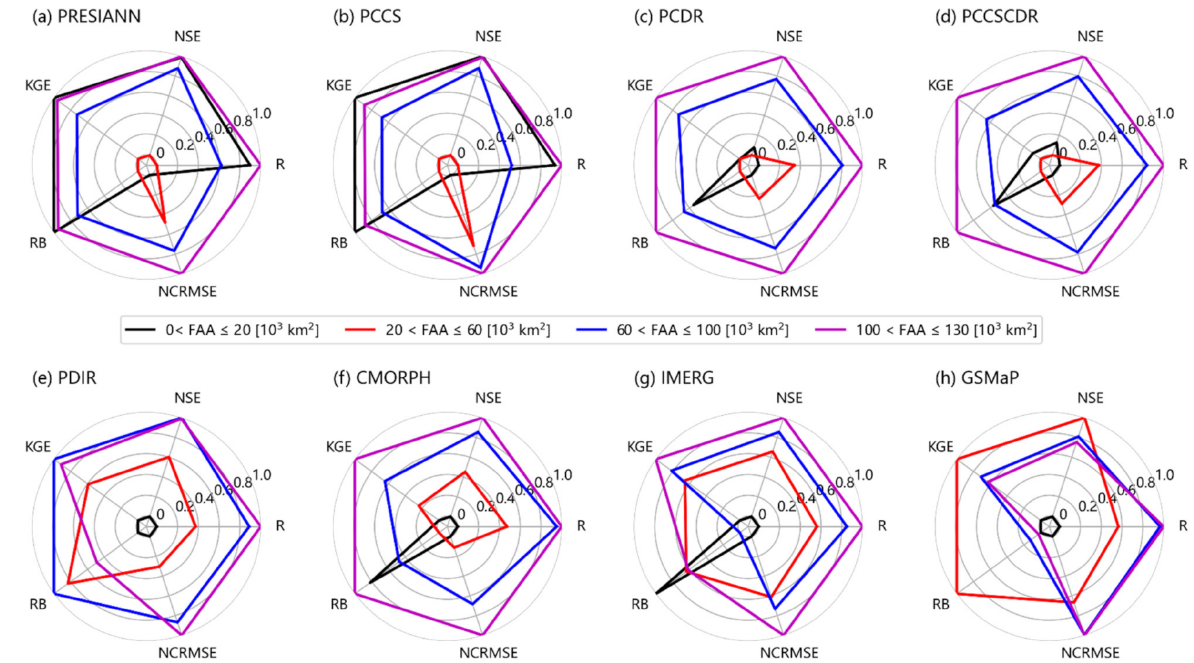
Figure 7. The relative goodness of the eight products ( a – h ) in the four catchment intervals with respect to five metrics. Pearson correlation coefficient (R); Nash–Sutcliffe efficiency (NSE); Kling-Gupta efficiency (KGE); Relative bias (RB); Normalized centered root mean square error (NCRMSE). The values shown in the figure are the median of each